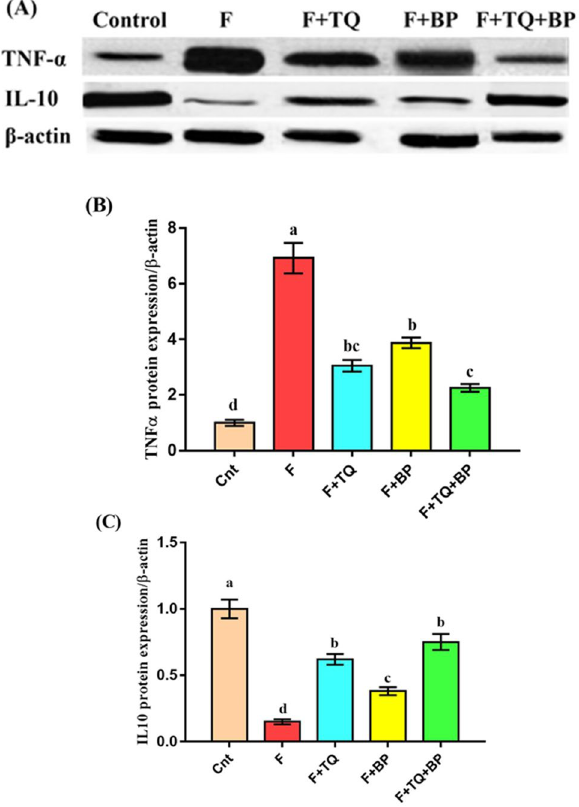
Figure 5. Western blot analysis shows changes in TNFα and IL10 protein expression relative to β-actin protein (control). ( A ) TNFα and IL10 protein bands. ( B and C ) Band quantification of TNFα and IL10 protein (ImageJ, https:// imagej. nih. gov/ ij/ index. html). Data presented as fold change (mean) ± SEM (n = 7/group). Columns carrying different letters [a (the highest value) – d (the lowest value)] are significantly different at p < 0.05. All groups were compared to each